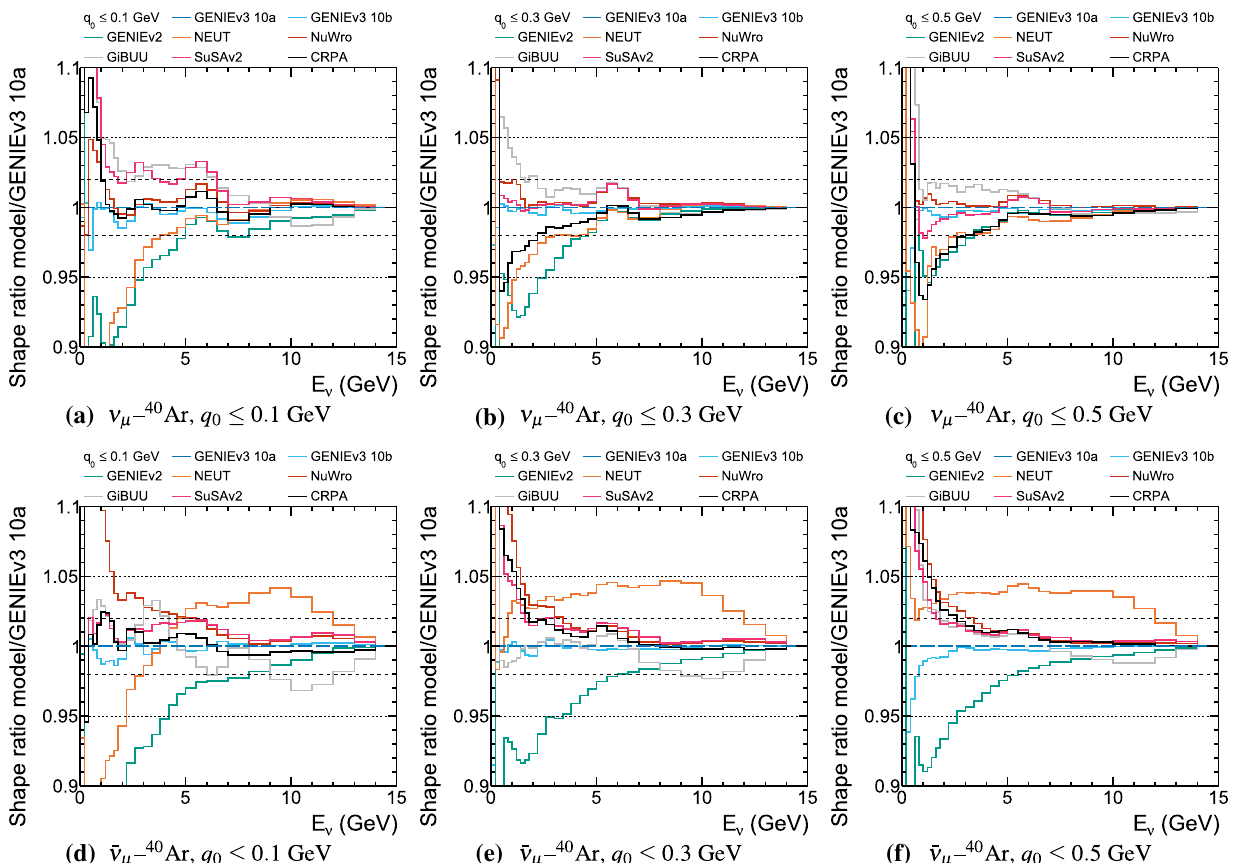
Fig. 4 Comparison of the shape-only ratios of the charged-current cross section with q 0 ≤ 0.1, 0.3 and 0.5 GeV as a function of E true ν , with respect to the GENIEv3 10a prediction. Shown for both ν μ – 40 Ar